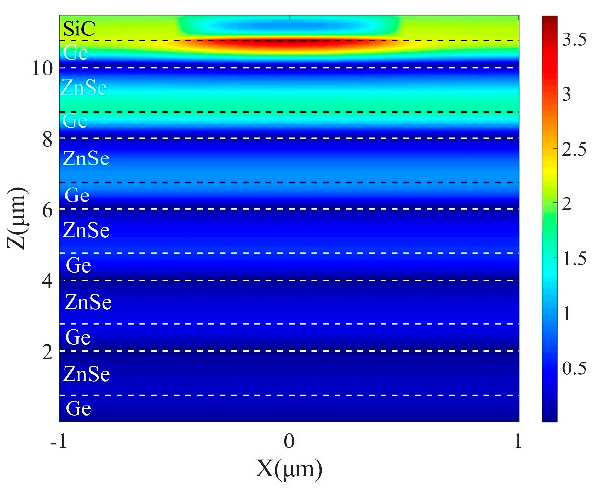
Figure 10. Magnetic field distribution of TM polarization in x − z plane with 5 DBR pairs with p = 2 μ m, f = 0.5 and d g = 0.7 μ m at λ = 12.35 μ m.